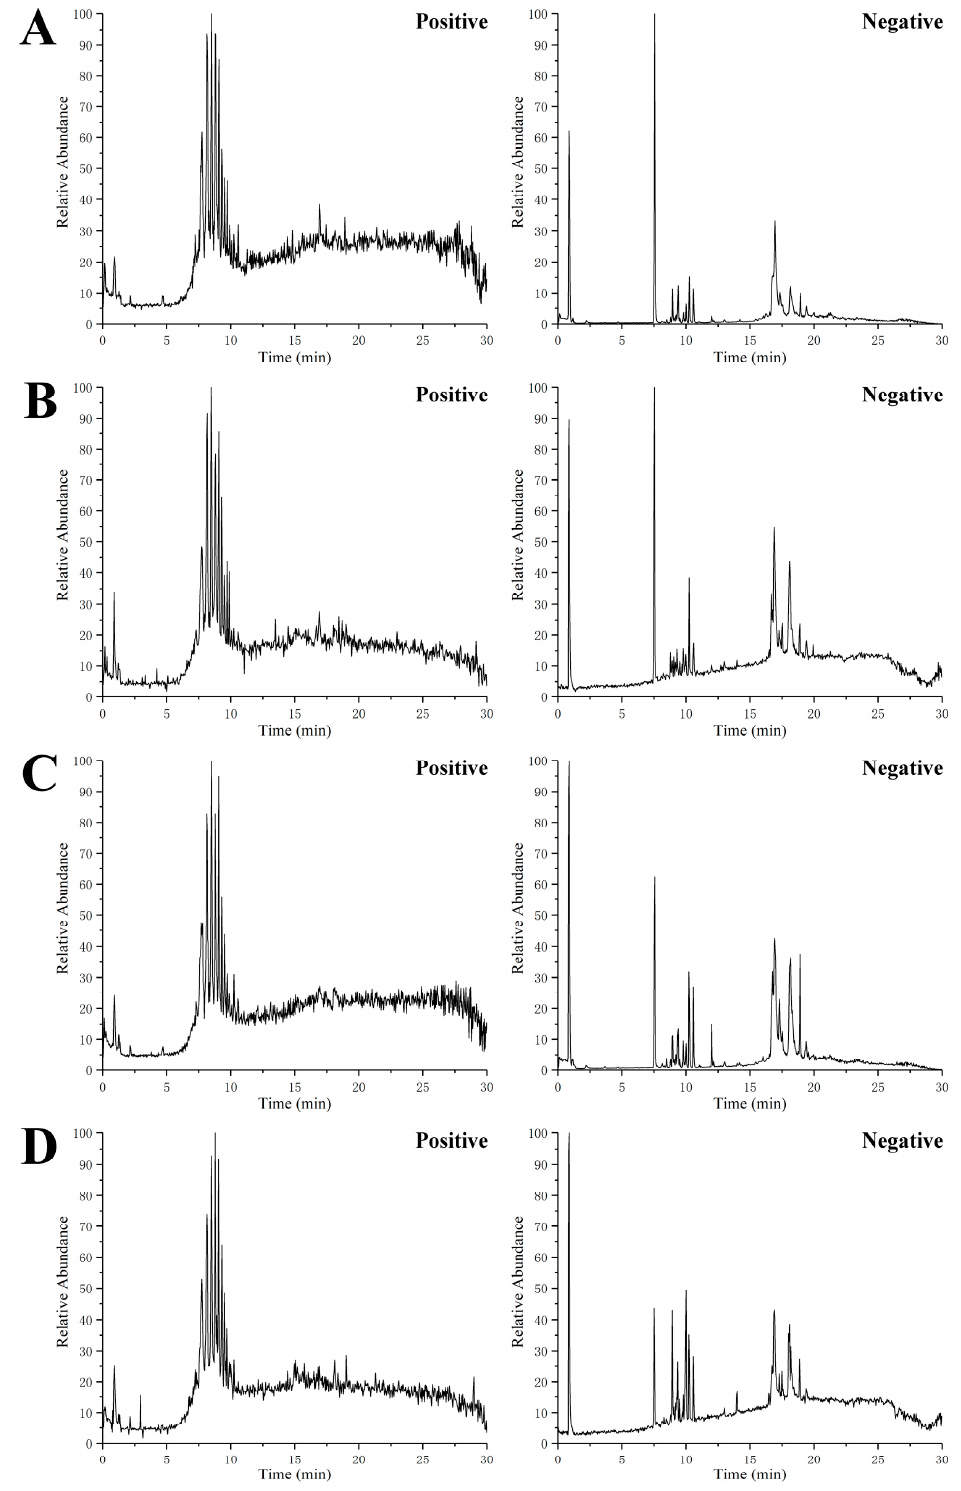
Figure 3. Representative UHPLC-MS total ion chromatograms (TIC) of serum from the control group ( A ), T2DM group ( B ), metformin group ( C ), and ginsenoside Re ( D ) group, respectively.